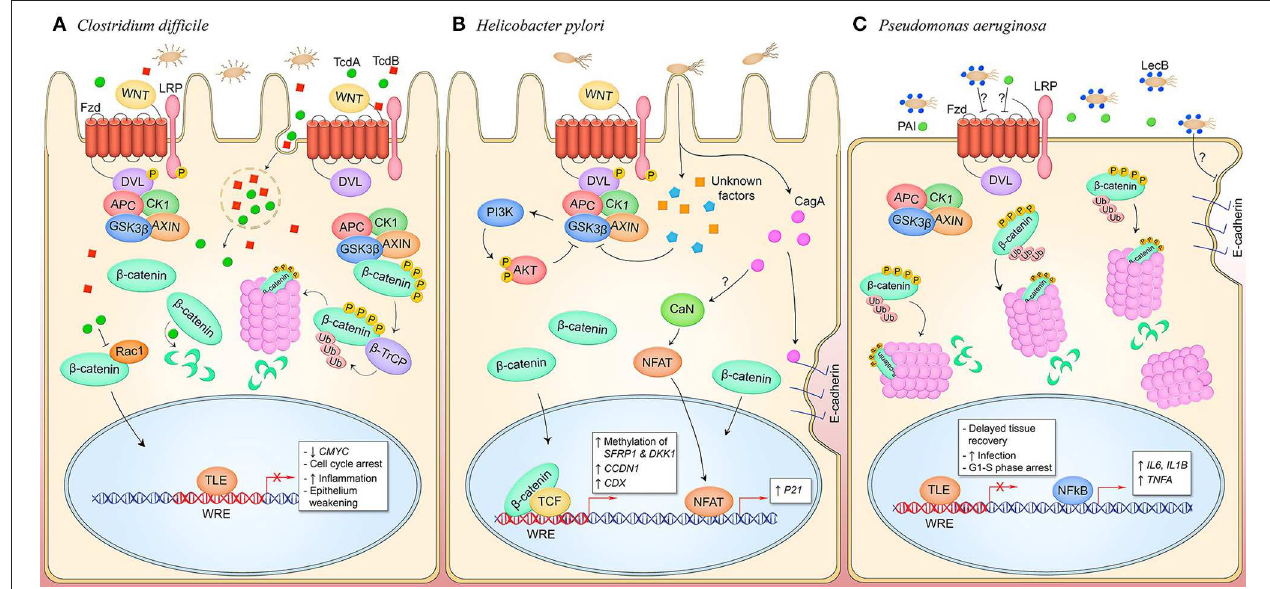
FIGURE 6 | Canonical and non-canonical Wnt signaling manipulation by pathogens occupying an extracellular niche. (A) C. difficile secretes toxins TcdA and TcdB which are phagocytosed by host cells in the intestinal and colonic epithelia. TcdA glucosyltransferase activity inhibits small GTPases like RacA which may inhibit pathway activity through inhibiting nuclear translocation of β -catenin. TcdB interacts with Wnt pathway components LRP6, Wnt5a, and GSK3 β , and Fzd1, 2, and 7. Direct binding of Fzds prevents binding of endogenous Wnt ligands and silences pathway activity. This promotes epithelium permeability and a pro-inflammatory state. (B) During H. pylori infection of gastric mucosa, CagA activates canonical Wnt signaling through the breakdown of adherens junctions, and non-canonical Wnt signaling through stimulation of CaN and NFAT nuclear translocation by an unknown mechanism. Canonical pathway signaling is also activated through unknown T4SS effectors that induce phosphorylation of LRP and DVL and inhibit GSK3 β , promoting cytosolic accumulation of β -catenin and subsequent nuclear translocation to activate genes that drive cell proliferation. Furthermore, unknown mechanisms induce methylation of Wnt pathway inhibitory genes SFRP1 and DKK1 to hypothetically facilitate Wnt signaling activity during infection. (C) P. aeruginosa is decorated with lectin LecB which induces β -catenin degradation through an unknown extracellular mechanism, resulting in decreased cell proliferation. Coincidentally, NF- κ B signaling is activated and inflammatory target genes IL6 , IL1B , and TNFA are expressed. LecB as well as the quorum-sensing molecule PAI both induce disruption of adherens junction in infected epithelia, contributing to prolonged tissue damage in the host.